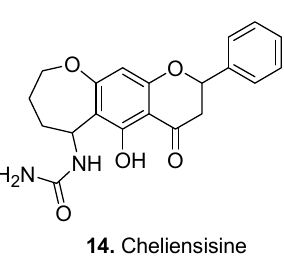
Figure 6. Cheliensisine ( 14 ).